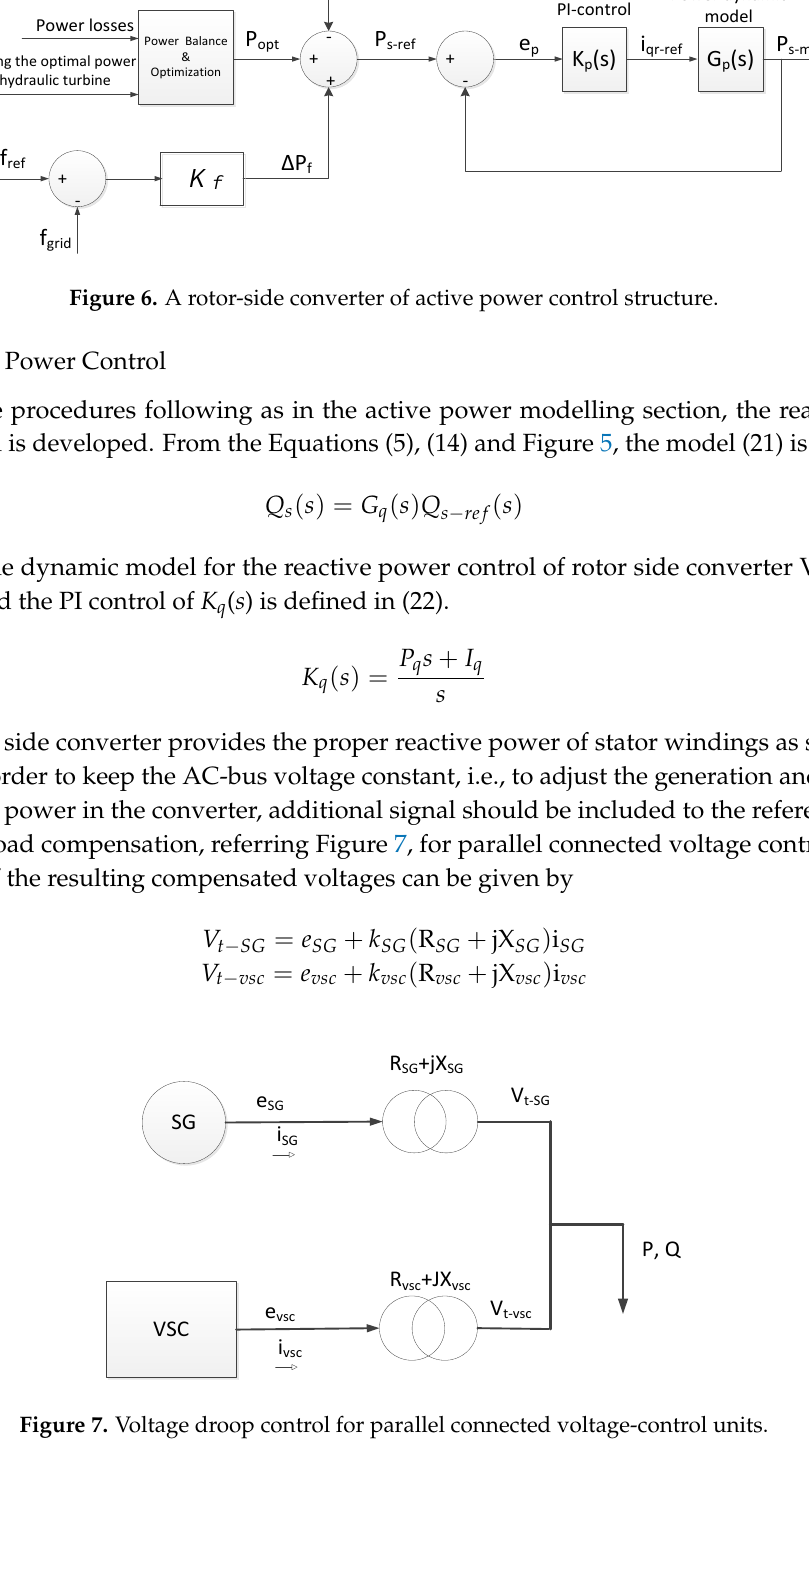
Figure 6. A rotor-side converter of active power control structure.